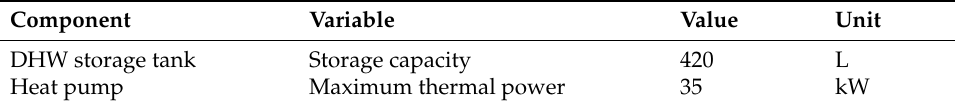
Figure 1. Schematic diagram for the reference system. Table 1. Sizing of the main components for the reference system.